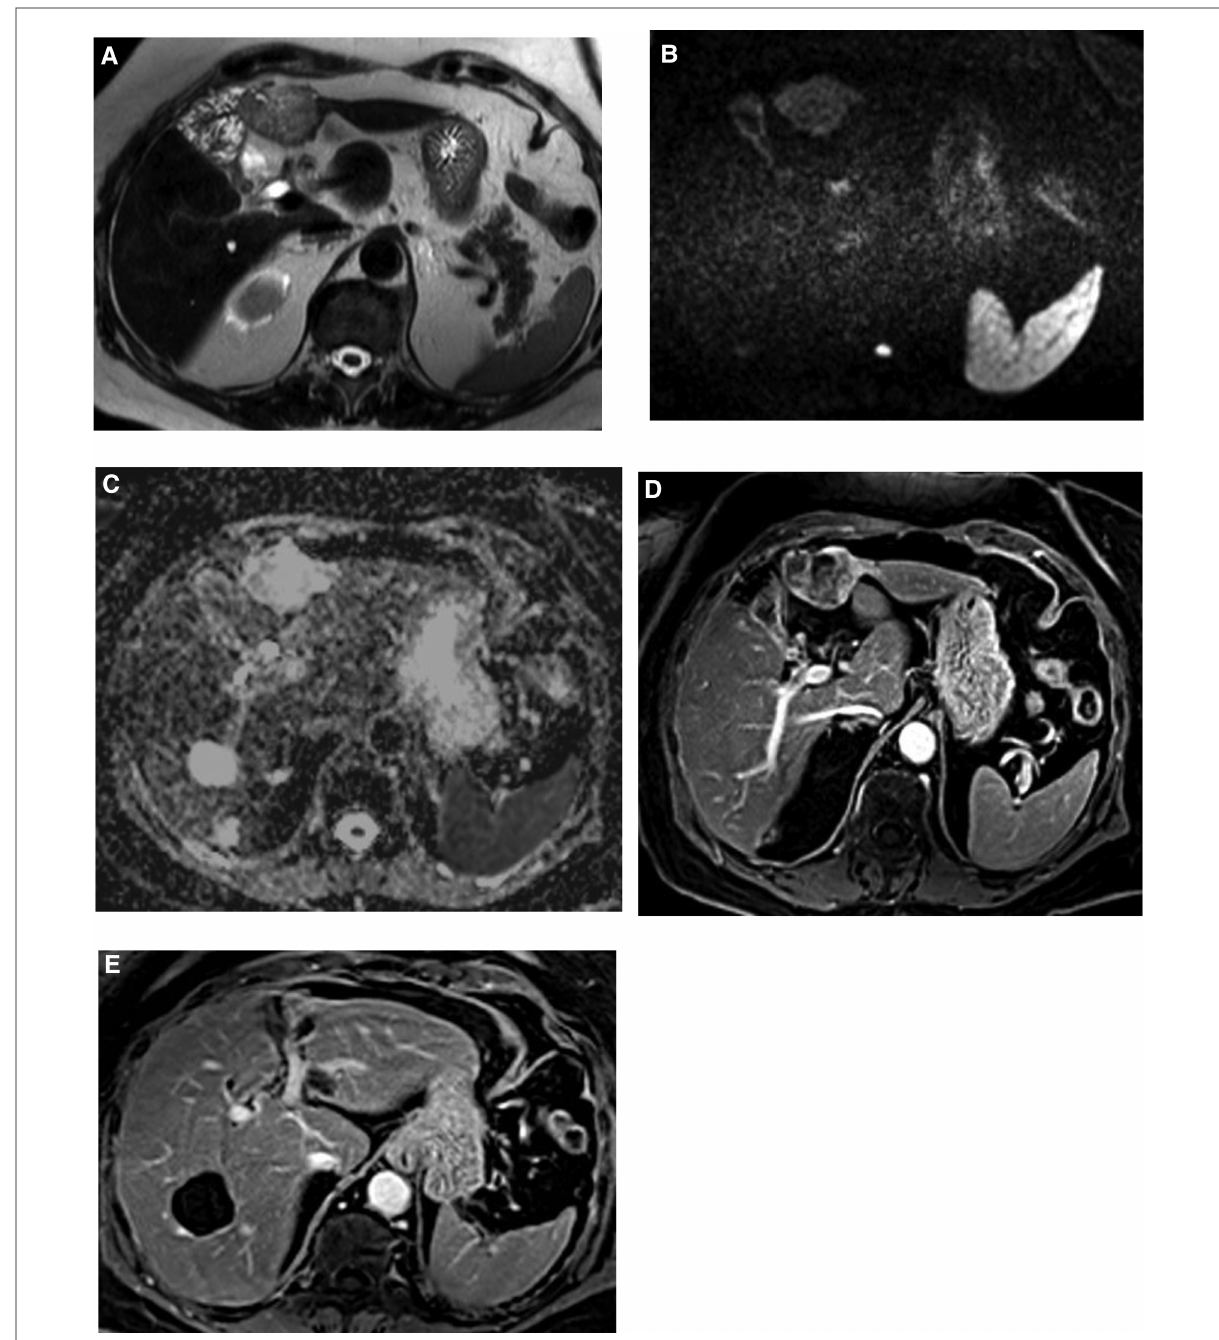
FIGURE 1 MRI images. Focal oval lesion straddling segments III and IVb showing sharp contours, heterogeneously high signal in T2 ( A ) and in diffusion- weighted imaging ( B ) corresponding to heterogeneous hypersignal on ADC map ( C ). Irregular and globally hypoenhancing behavior on T1 portal venous phase ( D ). ( E ) The lesion was located inferiorly to segmental left portal bifurcation, displaying a contact with the segmental branch for segment III without any major distortion or in fi